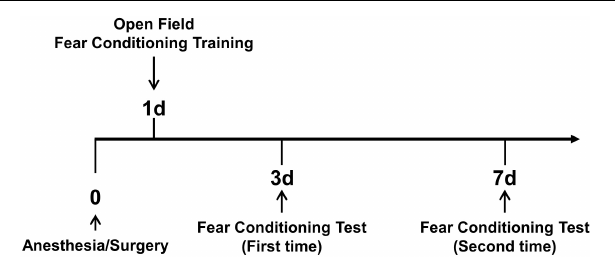
FIGURE 1 | Overview of behavioral analysis timeline. On the first day after anesthesia and surgery, the open field test and fear conditioning training were conducted. Then, on days 3 and 7 after anesthesia and surgery, fear conditioning tests were